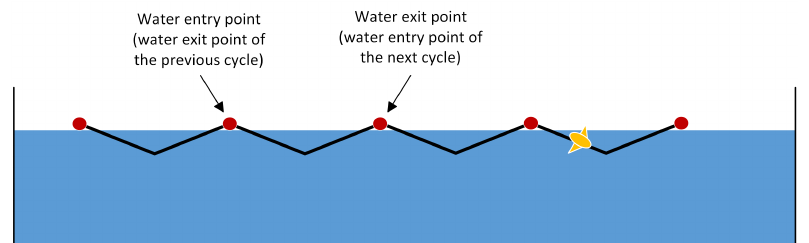
Figure 1. Multi-cycle saw-tooth motion of the HAUV in glider